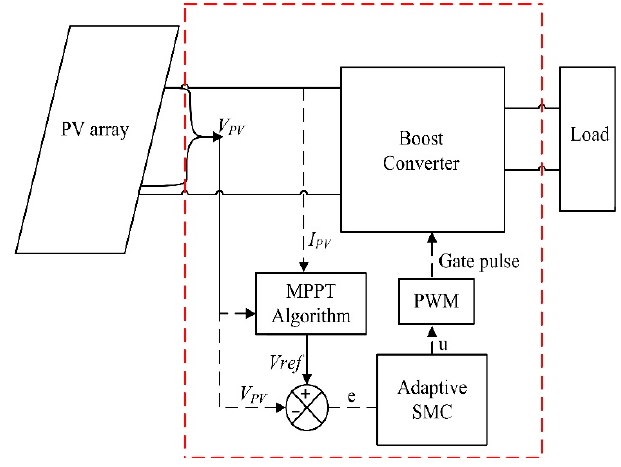
Figure 1. Block diagram of the system scheme based on adaptive sliding mode control.